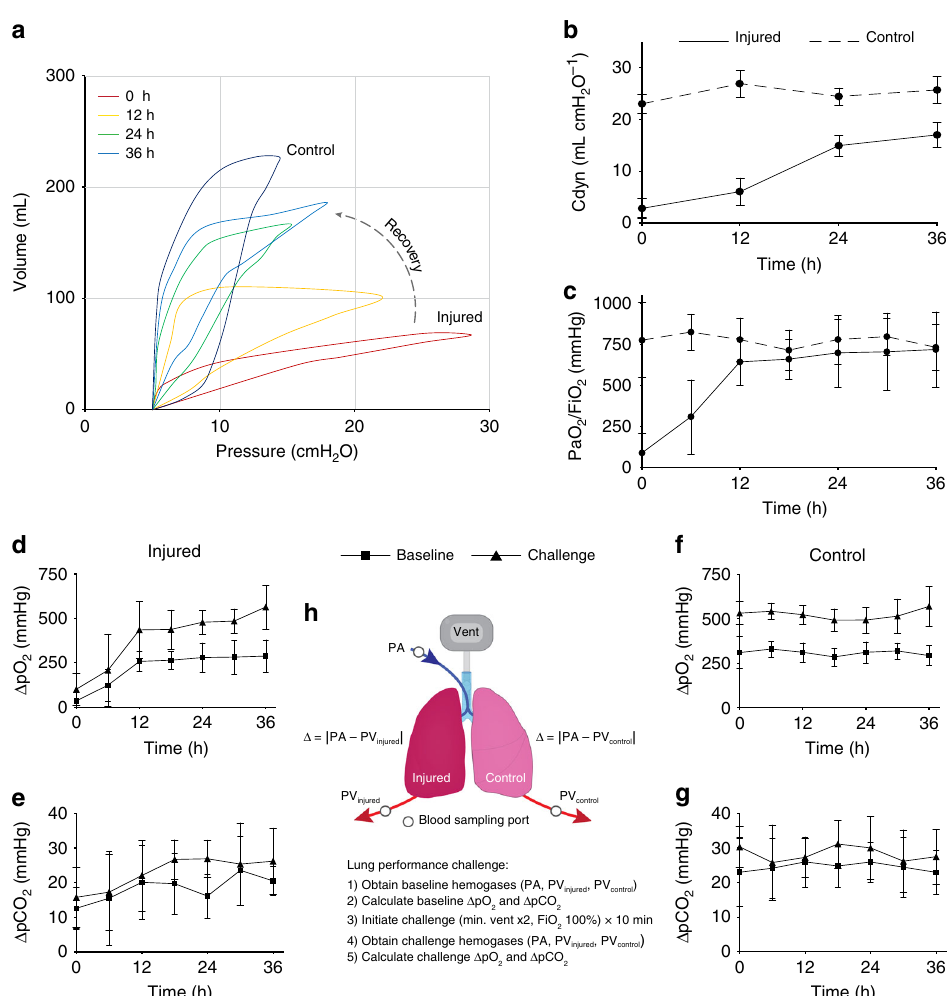
Fig. 4 Extracorporeal lung performance and functional recovery. a Pressure-volume (PV) loops: injured lungs demonstrating initial derangement in PV loops and recovery towards normal hysteresis observed in control lungs. b Dynamic compliance (Cdyn) over 36 h of cross-circulation. c PaO 2 /FiO 2 over 36 h of cross-circulation. Responses in Δ pO 2 and Δ pCO 2 to 10 min lung performance challenges throughout 36 h of cross-circulation in d, e injured and f, g control lungs. h Schematic depicts arterial and single lung venous blood sample collection and performance challenge protocol. All graphs represent data from n = 8 lungs. All values represent mean ± standard